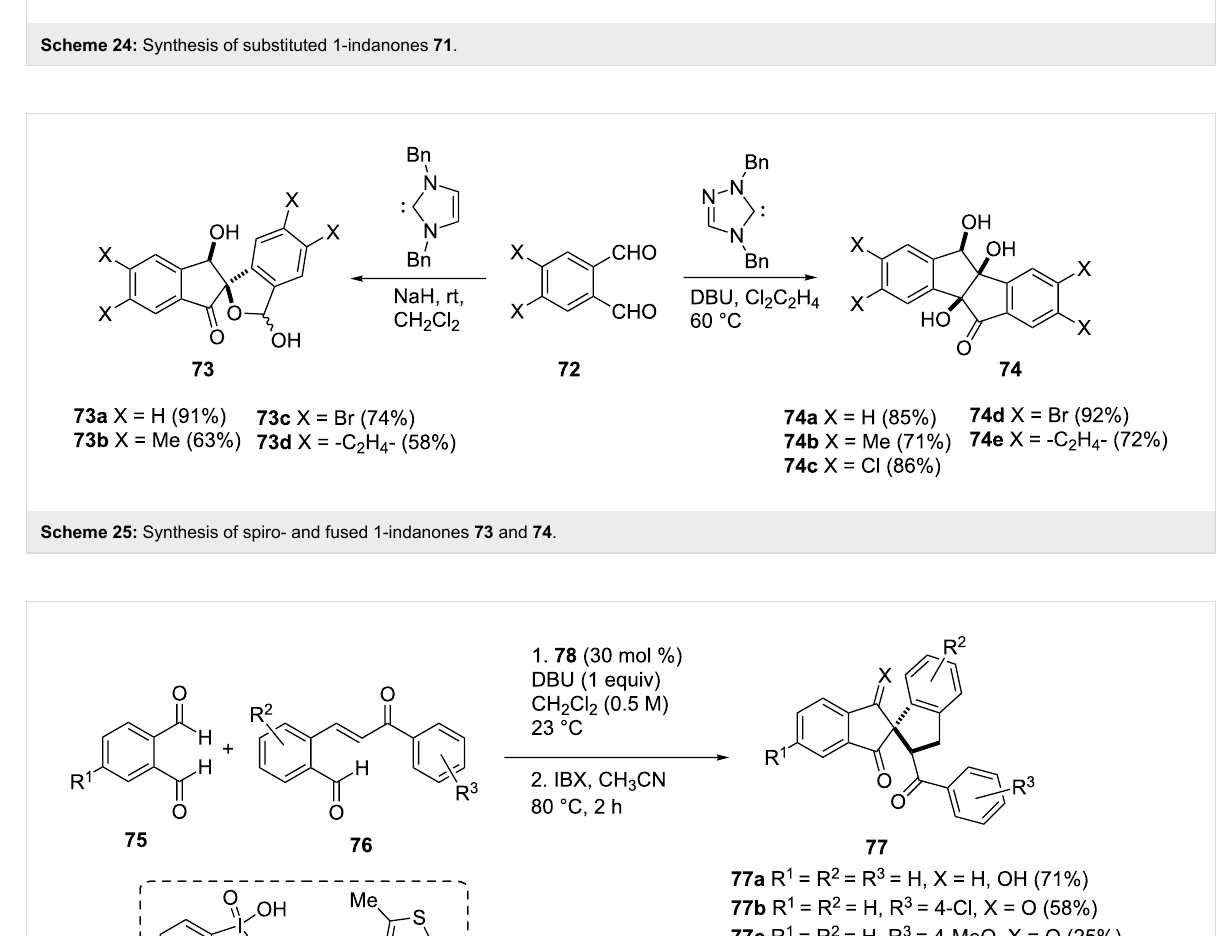
Scheme 24: Synthesis of substituted 1-indanones 71 .